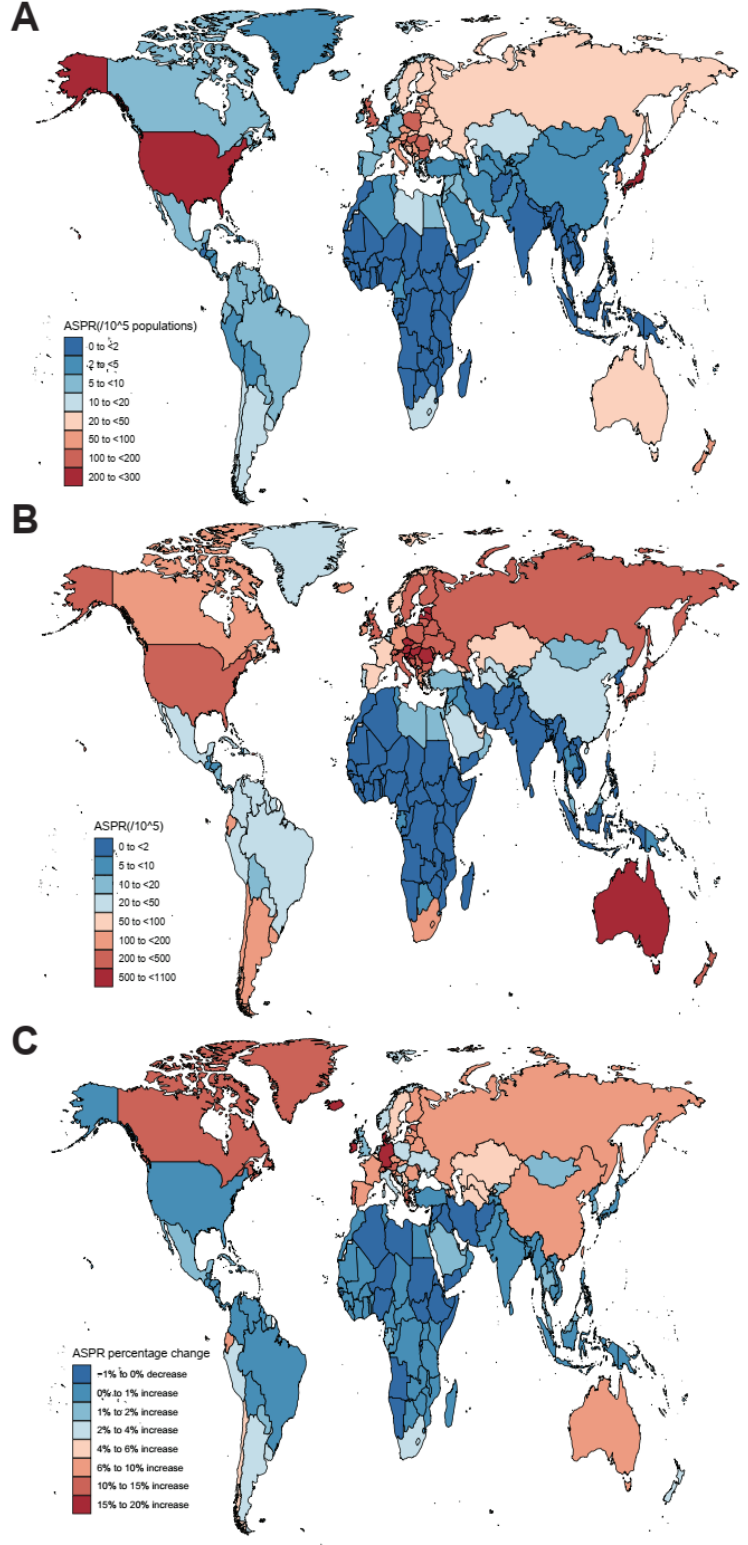
Figure 1. The global age-standardized prevalence rate (ASPR) of non-rheumatic calcific aortic valve disease (nrCAVD) in 204 countries and territories. ( A ) The ASPR of nrCAVD in 1990. ( B ) The ASPR of nrCAVD in 2019. ( C ) The relative change in ASPR of nrCAVD between 1990 and 2019.